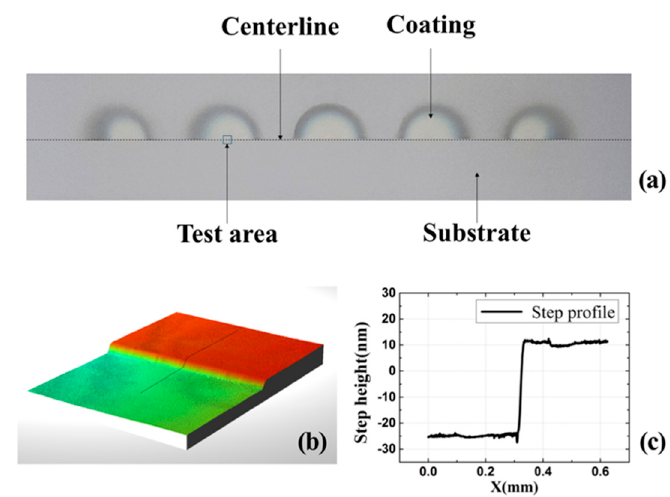
Figure 7. Step measurement by the optical profilometer. ( a ) Photo of the experimental sample with a step. ( b ) Measurement result of the optical profilometer. ( c ) Step height found by the results of the optical profilometer. Table 1. Detailed experimental parameters. The hole size on the mask and the distance of the mask between the target and the substrate are two